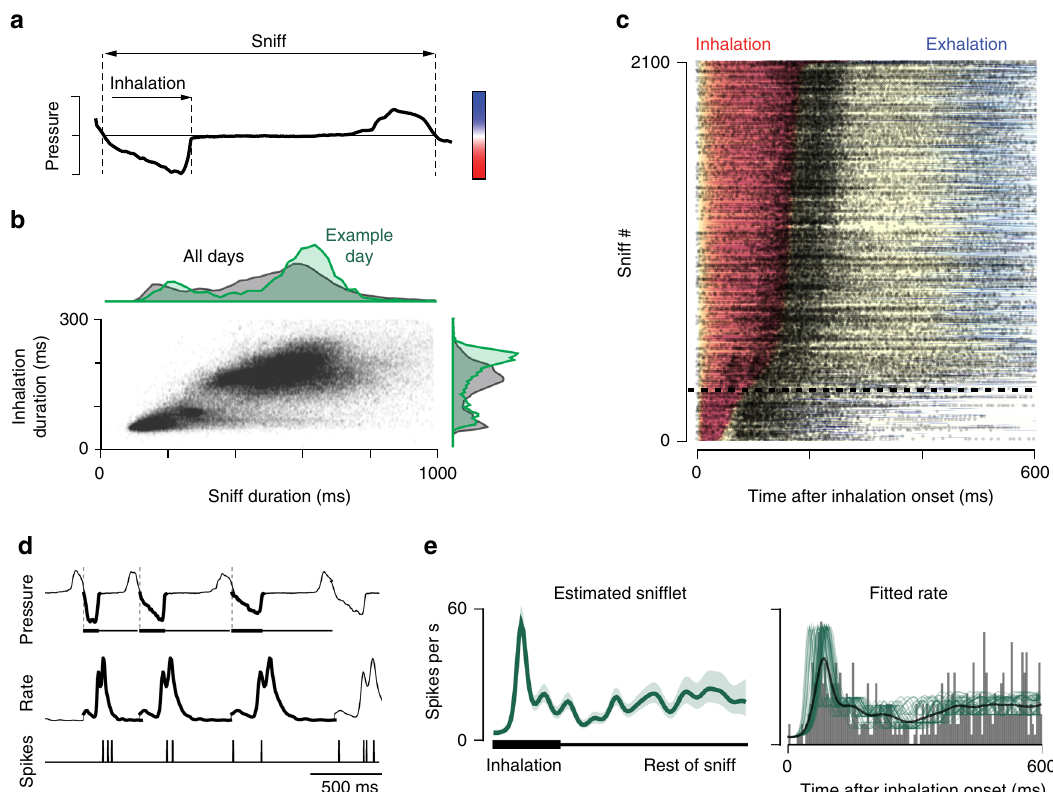
Fig. 2 MT cell activity depends on sniff dynamics. a A pressure signal showing one complete sniff cycle, recorded from the mouse nasal cavity. b Scatter plot of all inhalation and sniff durations, collated across mice. Top: marginal histogram of sniff durations, across all sessions and mice (black), and from one example session (green). Right: marginal histogram of inhalation durations. c Spiking of MT cells depends on inhalation duration. Black dots: raster of spike times of an example M72-MT cell across 2100 inhalations, during baseline (no odor) condition. Responses are aligned to the onset of inhalation, and are sorted (rows) by inhalation duration. Colored background shows sniff phase: red = inhalation; blue = exhalation. The color map is positioned in a , aligned with the pressure axis. Horizontal dashed line demarcates the rarer fast inhalations (below) from the more common slower inhalations (above). d Snif fl et model of MT cell responses. Top: pressure traces of three successive sniffs of short, medium, and longer inhalation duration. Inhalation periods illustrated with thickened lines. Middle: a model fi t of the sniff-induced fi ring rate of the MT cell following a particular temporal pattern, denoted as a “ snif fl et ” . Bottom: the observed spikes. The time courses of the snif fl ets are the free parameters of the model; these are fi tted to each cell, for each stimulus condition, given the observed spikes. e Snif fl et fi t to an example M72-MT cell response to a single odor. Left: estimated snif fl et for this cell/odor. Shaded region: ±1 SEM. Here and further: the time axis for a snif fl et is shown as a thick bar corresponding to the normalized duration of inhalation, followed by a thin bar for the rest of the normalized sniff. Right: gray bars show the trial-averaged PSTH; thick black line shows average fi ring rate across trials; thin green lines show the model- fi tted fi ring rates on each trial, given the dilations induced by different